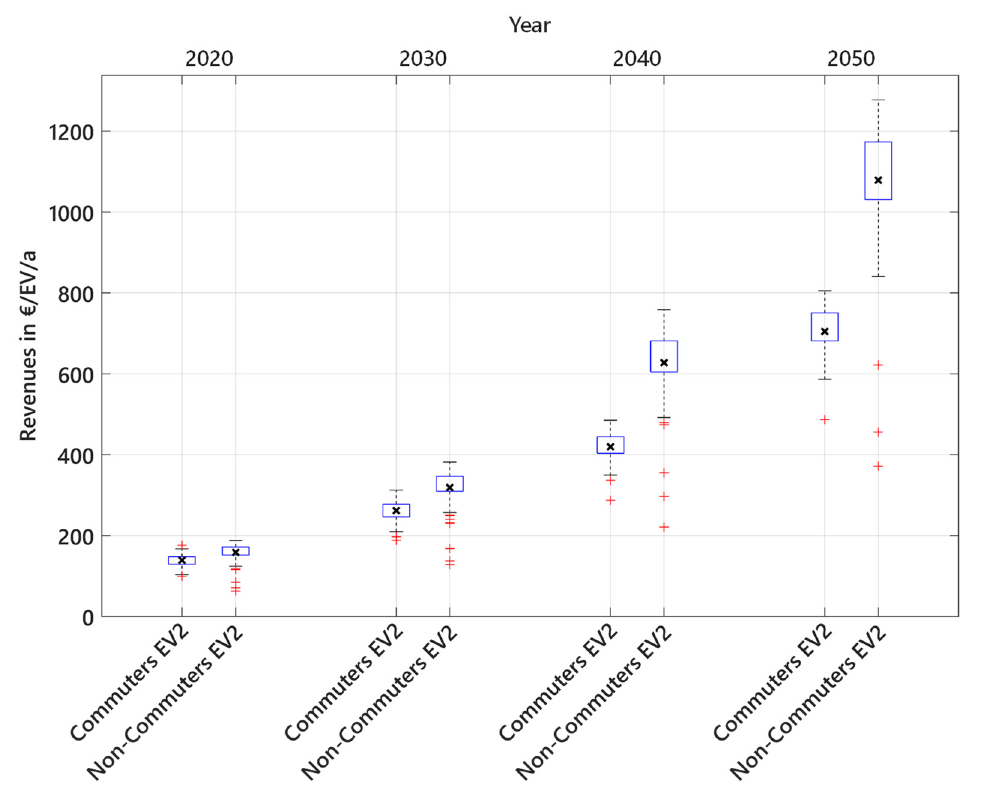
Figure 5. Revenues of bidirectionally chargeable EVs compared in accordance with future hourly day-ahead market prices.